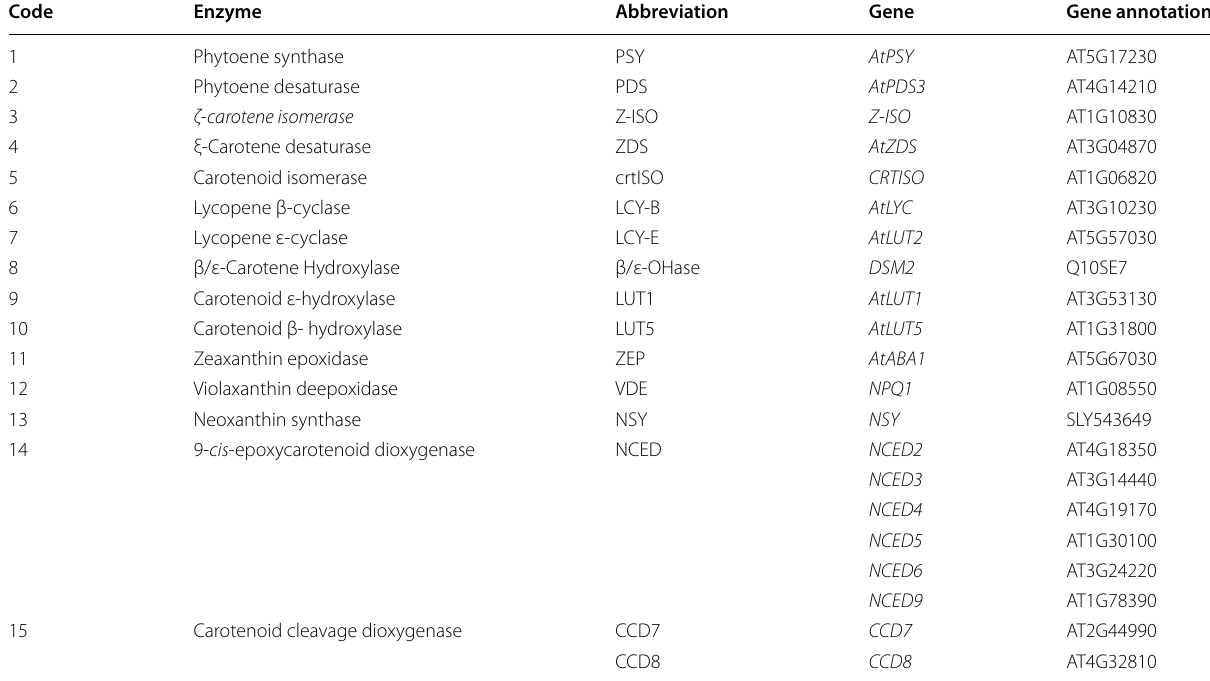
Table 2 Genes and enzymes involved in carotenoids biosynthesis in plant